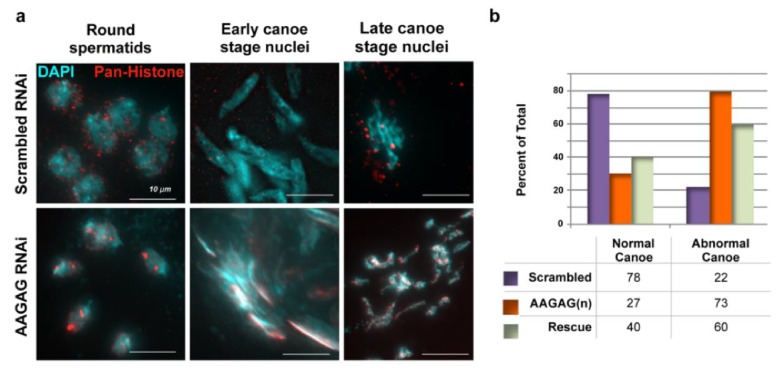
Histones are retained and DNA morphology is altered in late canoe stage AAGAG RNAi testes.(a) Histones are retained until late canoe stage with AAGAG RNAi in primary spermatocytes but removed by early canoe stage in scrambled RNAi. (b) Canoe stage nuclei exhibit abnormal morphology with AAGAG RNAi, and this morphology is partially restored with AAGAG(37) rescue.